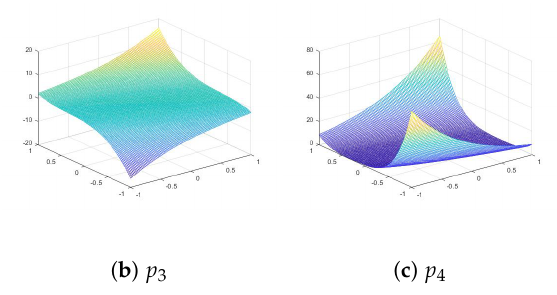
Figure 7. Plot of polynomials p i , i = 1, . . . ,4, in [ − 1,1 ] × [ − 1,1 ]